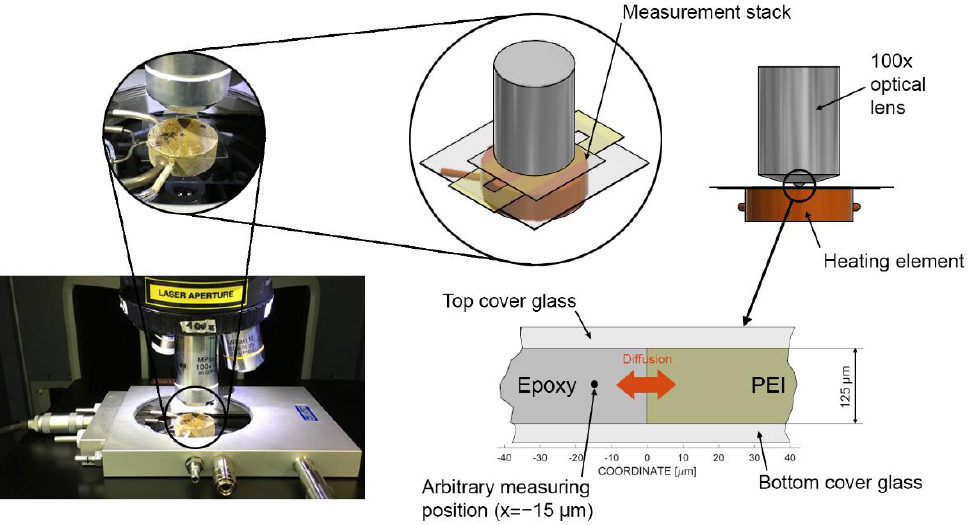
Figure 1. Adapted measurement stack of the in situ Raman spectroscopy coupled with hot stage microscopy including a thermoplastic film with an epoxy gap.